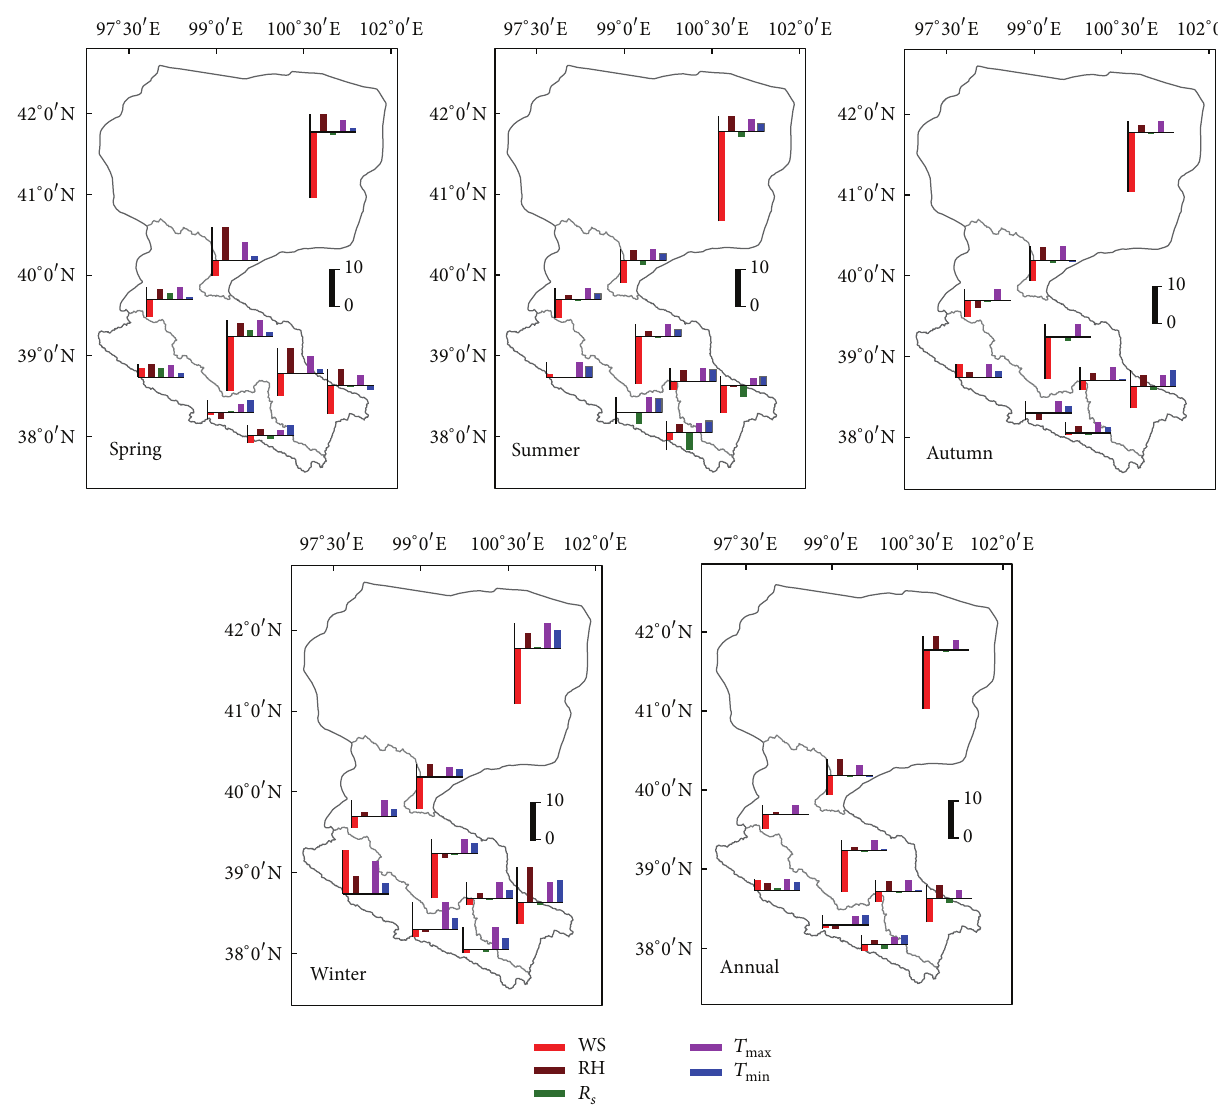
Figure 13: Contributions of meteorological factor changes to relative changes in ET 0 at annual and seasonal time scales for the stations in the HRB. An upward bar means that the factor trend causes a positive change in ET 0 , and a downward bar means that the factor trend causes a negative change in ET 0